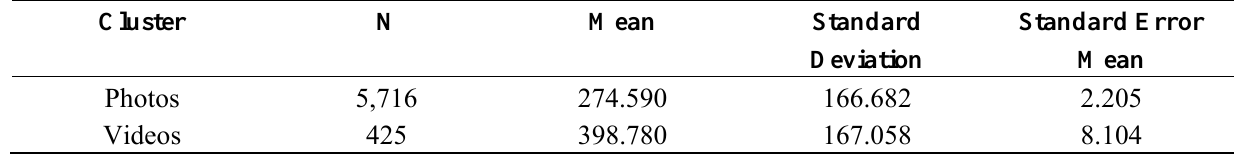
Table 9. Descriptive statistics: photos vs . videos (speed of retweeting).